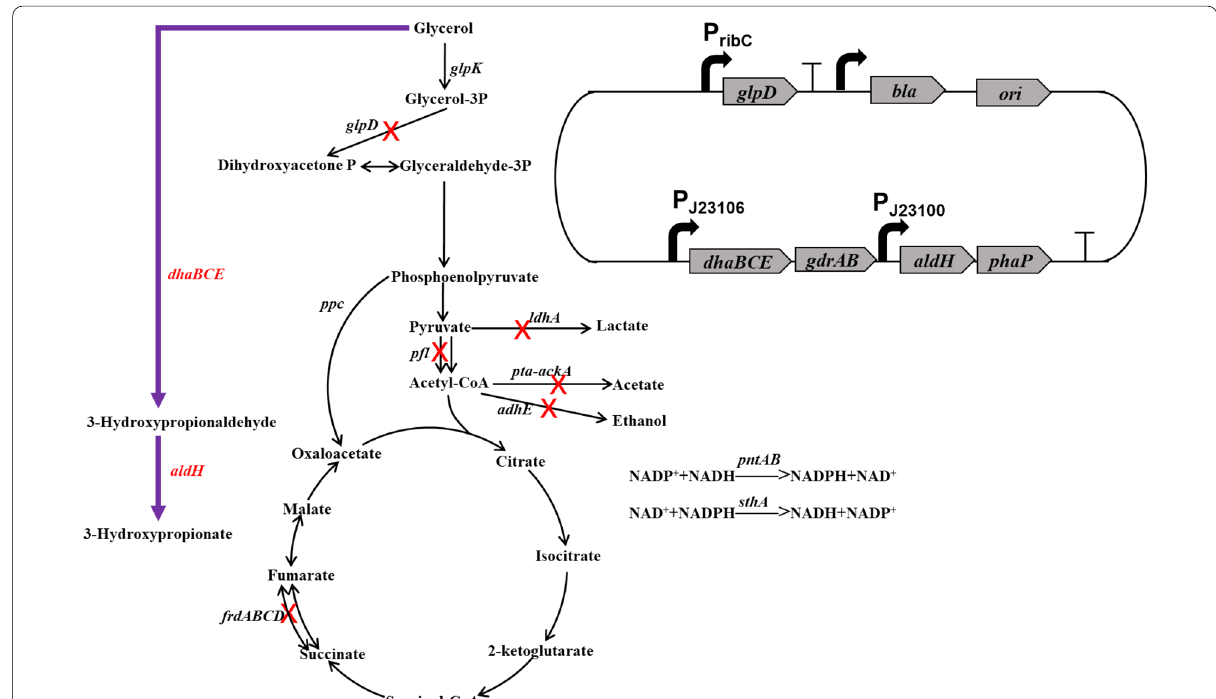
Fig. 5 Application of the plasmid maintenance system for developing V. natriegens to produce 3-HP. The deleted genes are shown with cross marks. A heterologous 3-HP synthesis pathway is introduced by overexpressing genes encoding glycerol dehydratase ( dhaBCE ) and its activator ( gdrAB ) and a NAD-dependent aldehyde dehydrogenase ( aldH ). A plasmid stabilization system is developed by deleting the chromosomal glpD gene encoding glycerol-3-phosphate dehydrogenase and expressing the corresponding gene in the expression